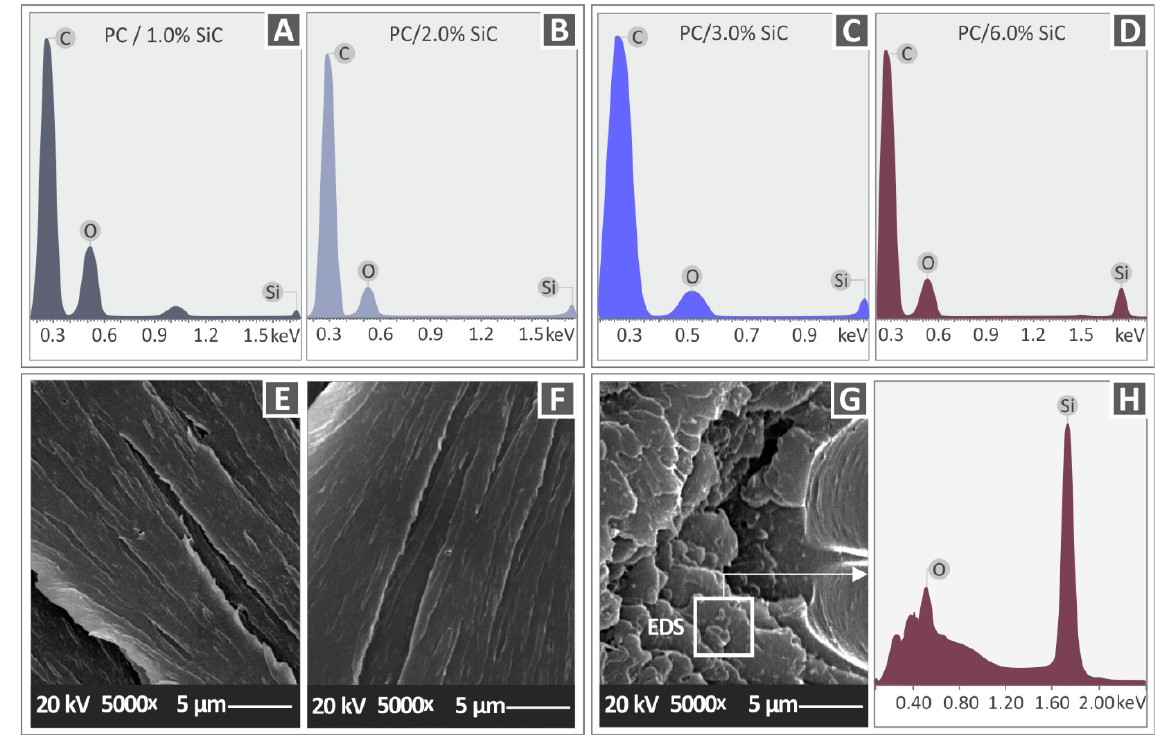
Figure 12. PC/SiC nanocomposite EDS graphs: ( A ) 1 wt.%, ( B ) 2 wt.%, ( C ) 3 wt.%, and ( D ) 6 wt.%. PC/SiC nanocomposites at 5000× magnification SEM micrographs of the fracture surface: ( E ) 1 wt.%, ( F ) 6 wt.%, ( G ) 3 wt.%, and ( H ) EDS graph on the area marked in Figure 12G.